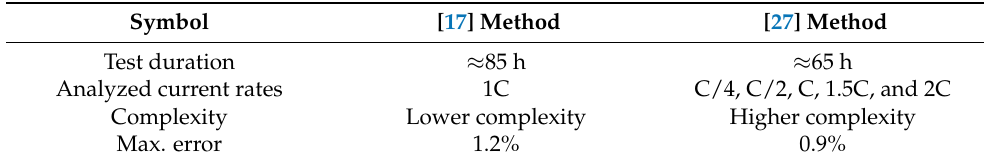
Table 1. Comparison between two different pulse test